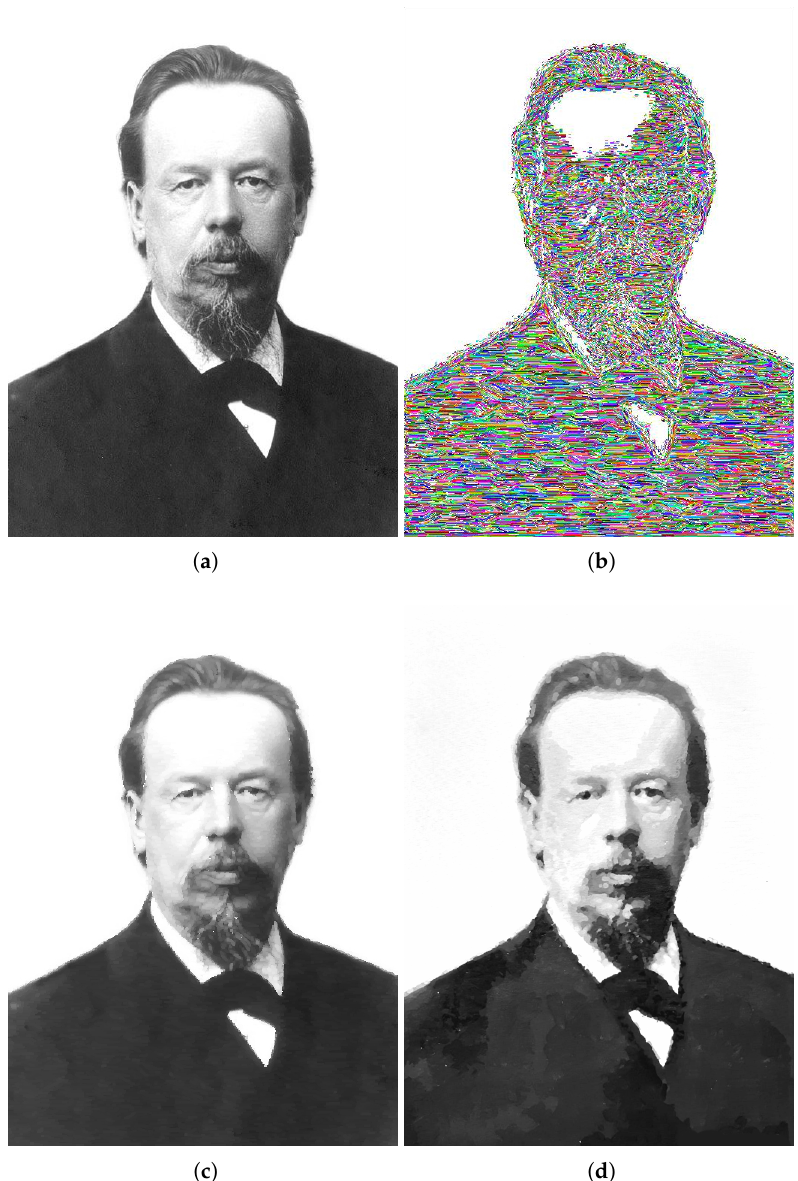
Figure 11. A slightly noisy source image ( a ) containing a number of monotonic areas can be rendered with well-coherent strokes generated with the technique of coherence enhancement ( b ). The rendered image ( c ) is then painted with the robot ( d